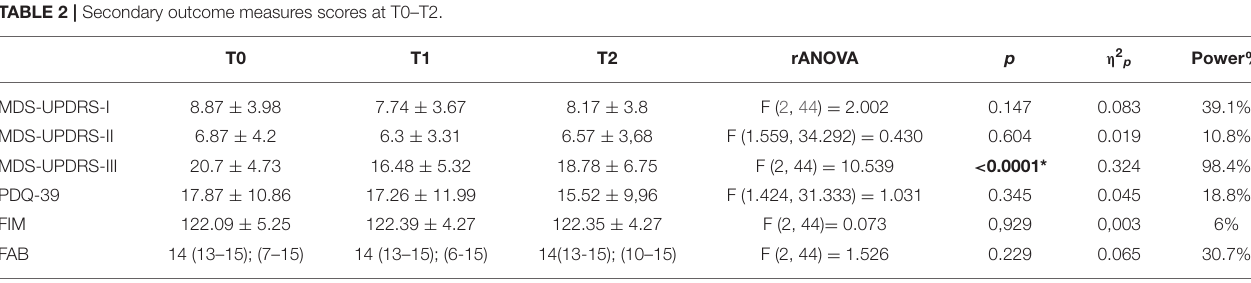
TABLE 2 | Secondary outcome measures scores at